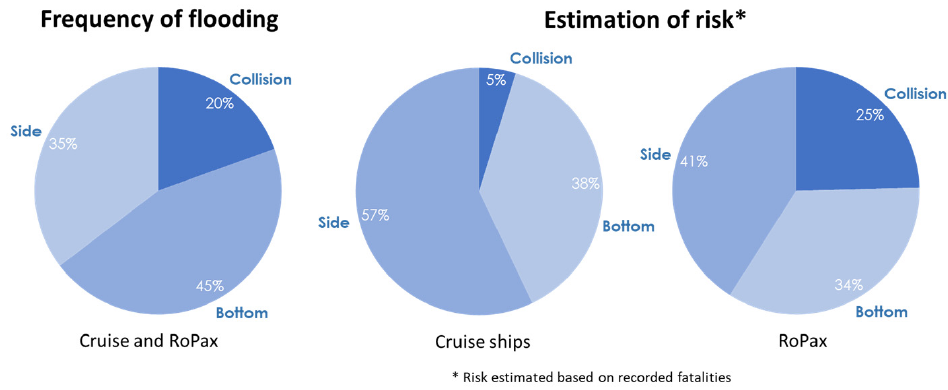
Figure 8. Recent statistics on the flooding risk of passenger ships, Project FLARE [12].